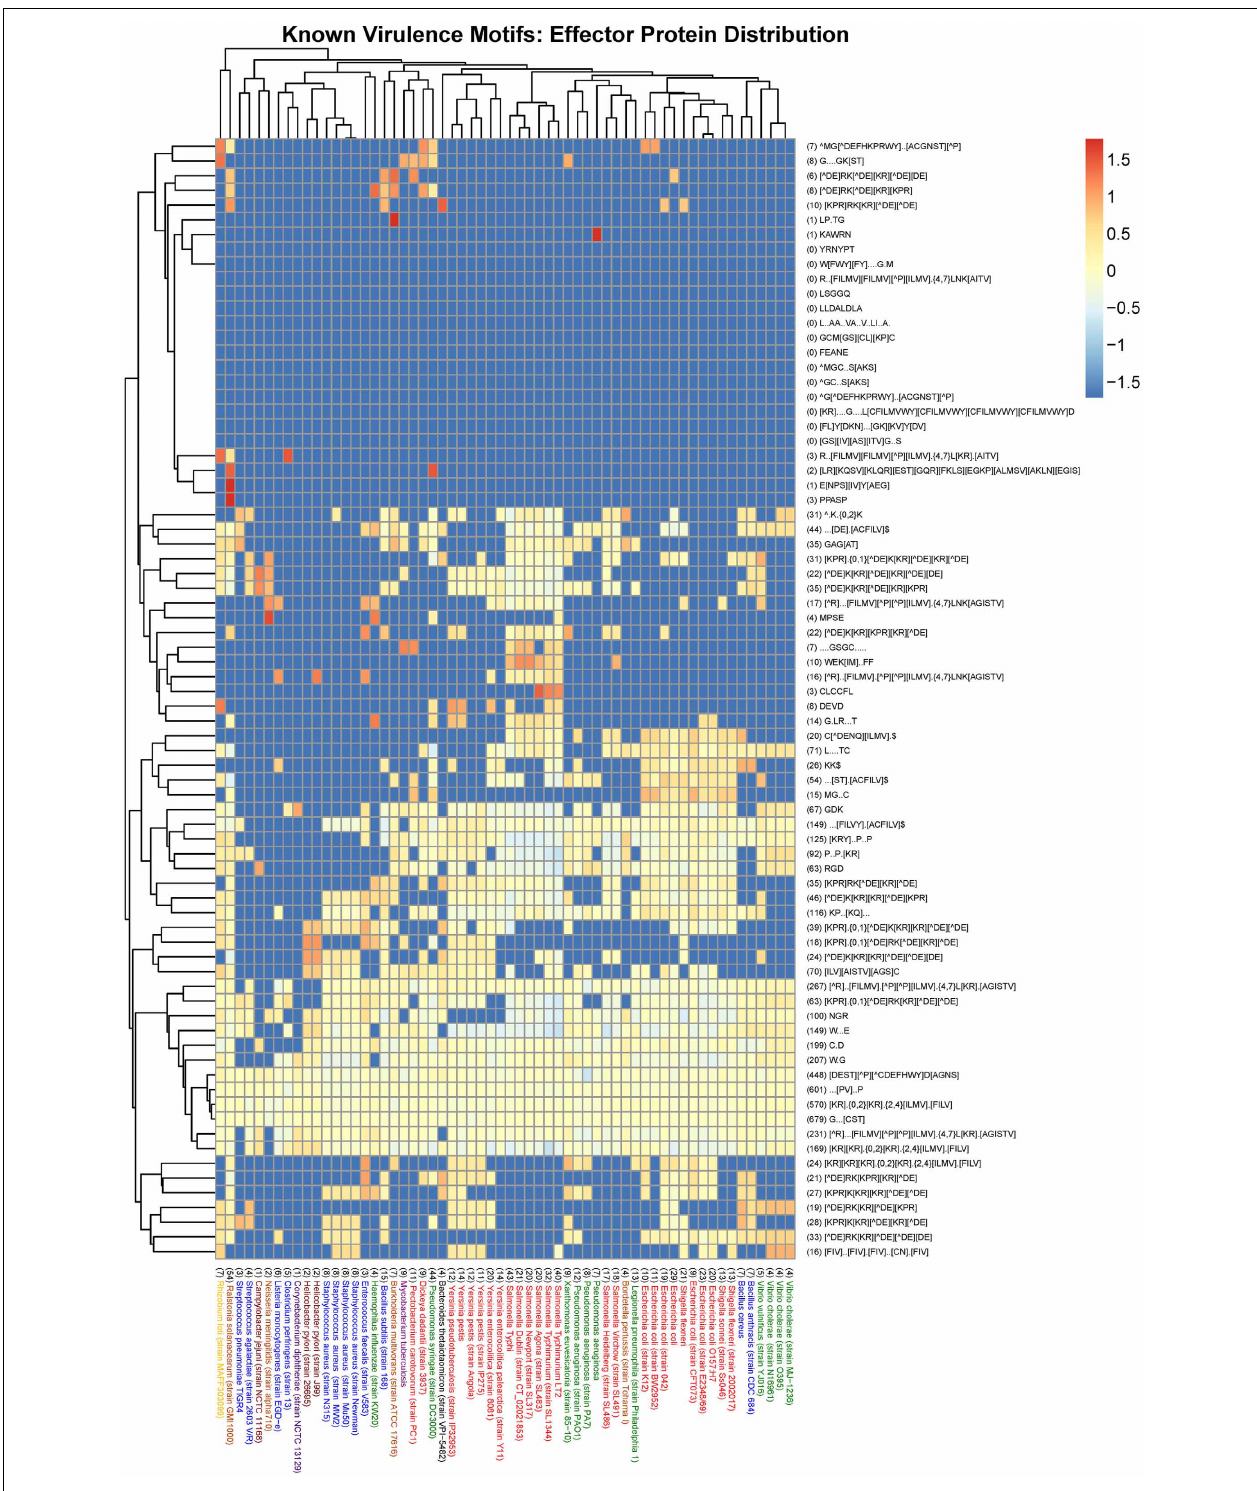
FIGURE 3 | Heat map visualization of the distribution of known virulence motifs amongst effector proteins from a selection of 60 organisms represented in the MvirDB. Columns: The bacterial species name with the total number of UPCs indicated in brackets at the start of the description. Purple, High GC Gram+ bacteria; Blue, Firmicutes; Yellow, a-proteobacteria; Light Brown, b-proteobacteria; Dark Brown,